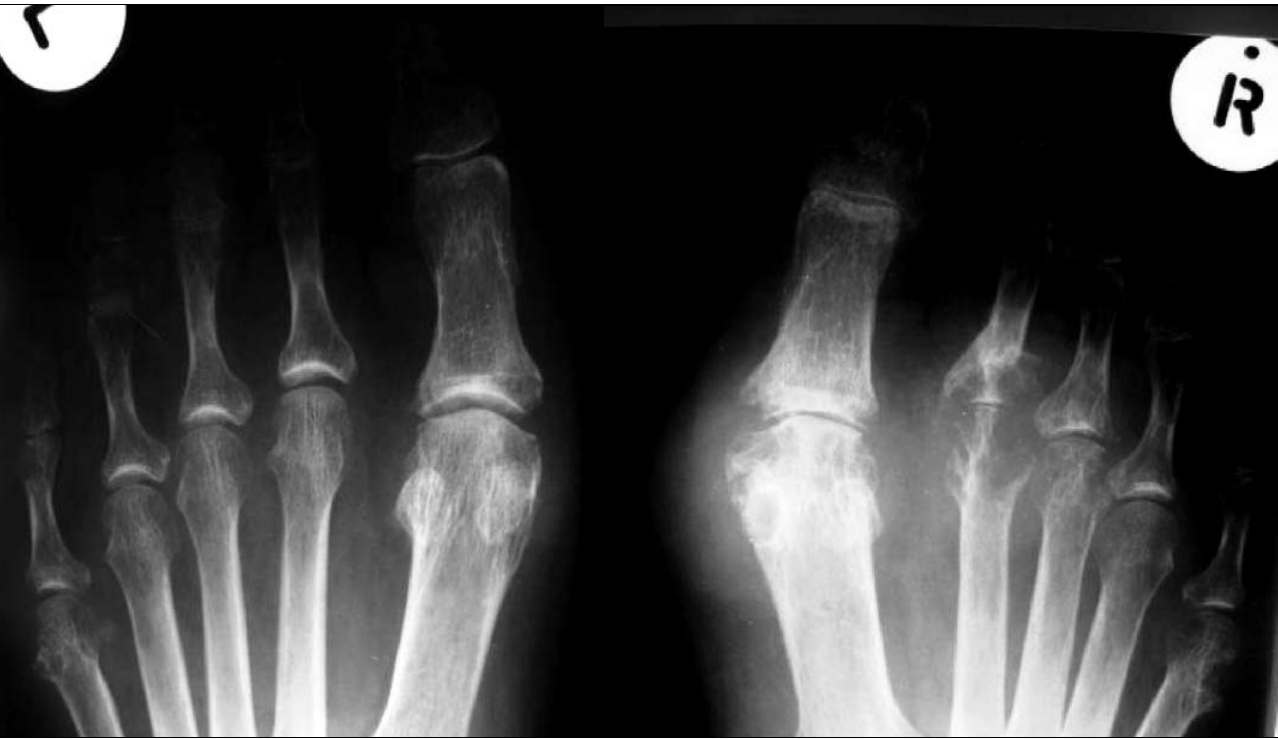
Fig. 1. Anteroposterior radiograph of the feet demonstrates first MTP joint involvement on the right. Note the eccentric, dense soft-tissue swelling and para-articular erosions. The sub-articular lucencies represent intra-osseous tophi. There is also involvement of the second, third and fifth metatarsals on the right, and fifth MTP joint on the